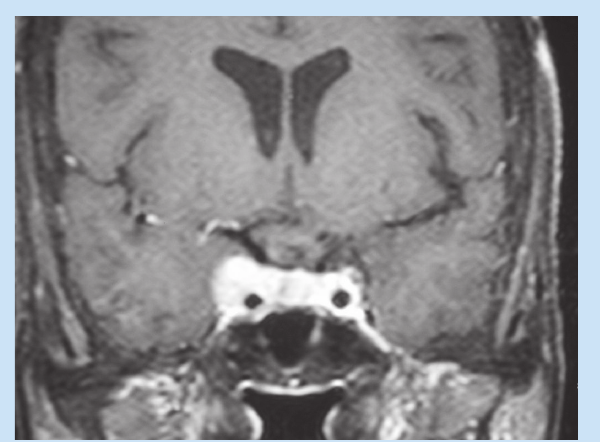
Fig. 5. Extension into right cavernous